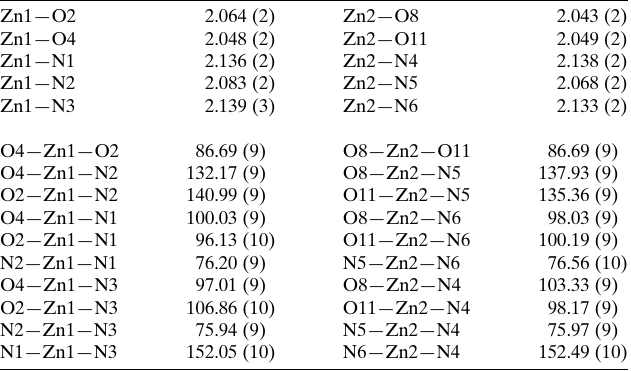
Table 2 Experimental